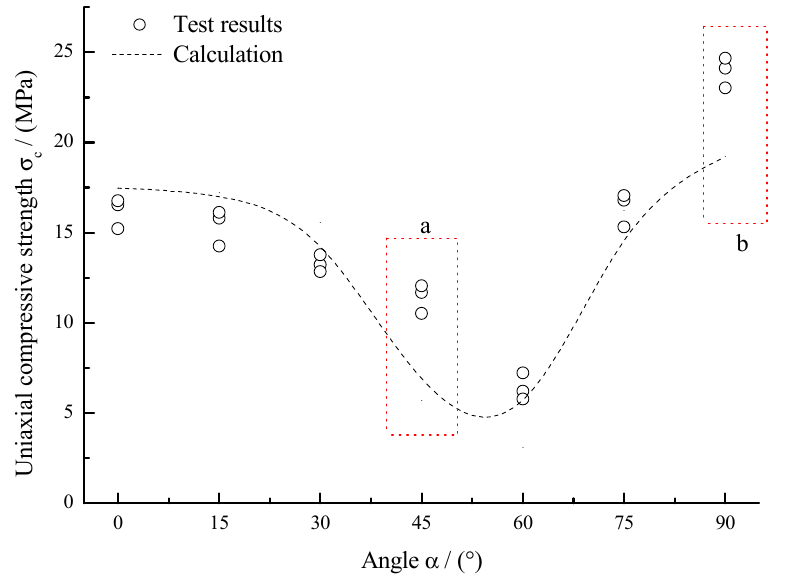
Figure 14. Theory versus test. The calculation results were obtained by data fitting in Table 2.